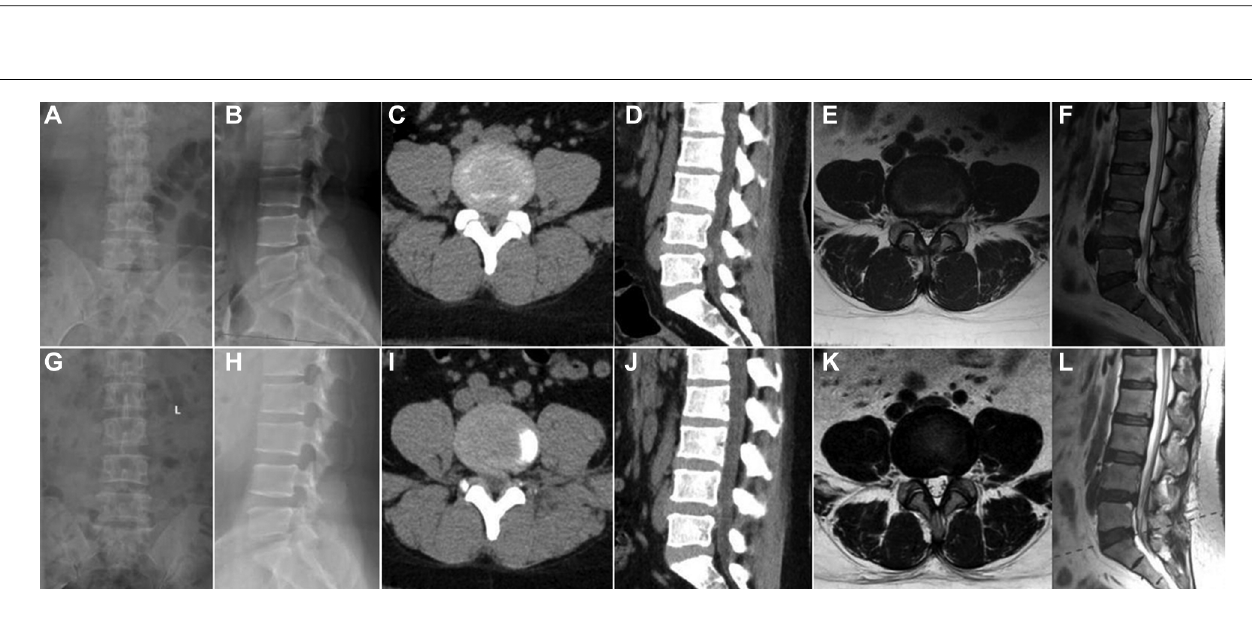
FIGURE 4 Pre- and postoperative x-ray, CT and MRI of PTED. ( A,B ) Preoperative x-ray. ( C – F ) Preoperative CT and MRI showing disc herniation. ( G,H ) Postoperative x-ray. ( H,I ) Postoperative CT and MRI showing the disc was